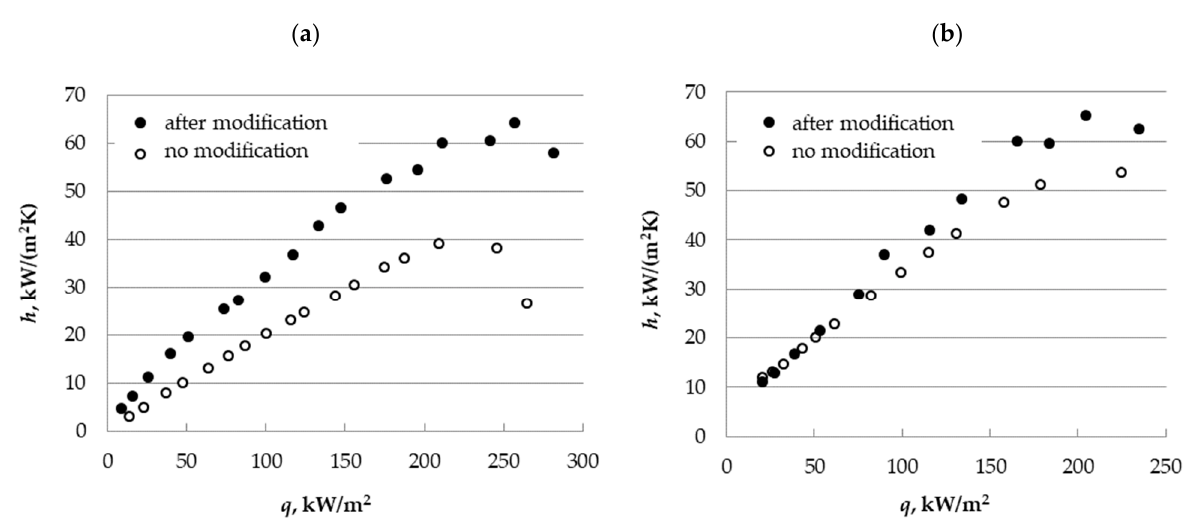
Figure 6. Effect of the modification on HTC at G = 420 kg/(m 2 s) in the T4 thermocouple section, ( a ) p r = 0.43, ( b ) p r = 0.56.